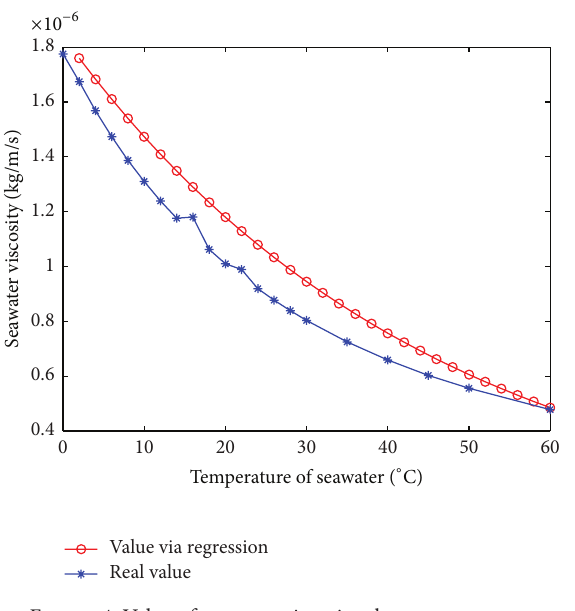
Figure 4: Value of seawater viscosity along temperature.